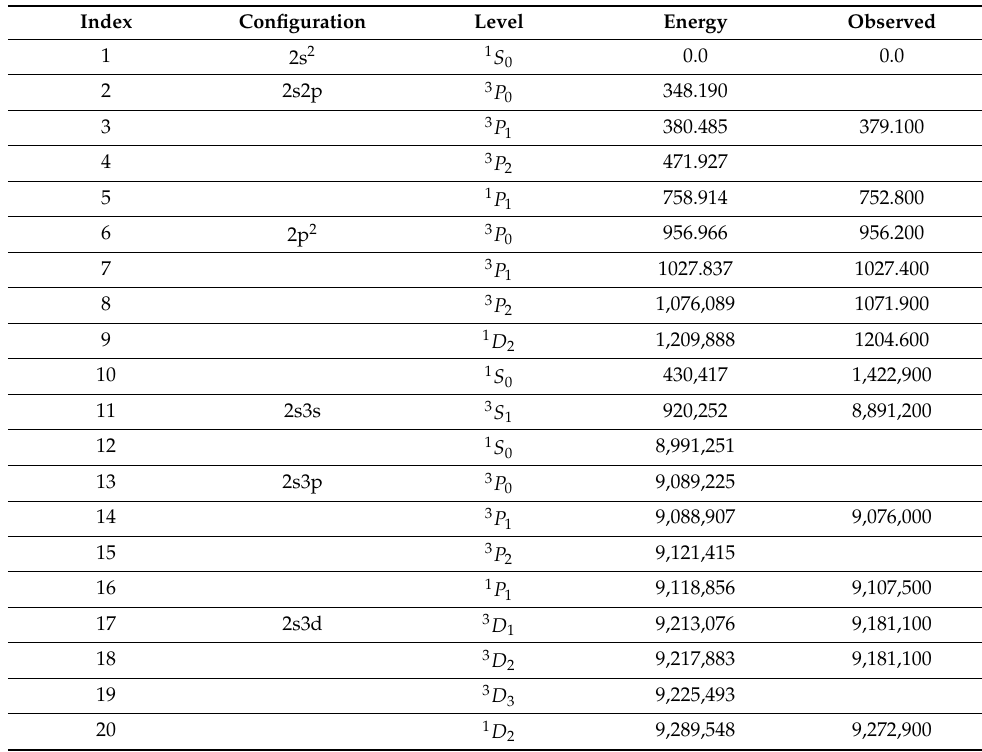
Table 15. Levels and energy values (cm − 1 ).